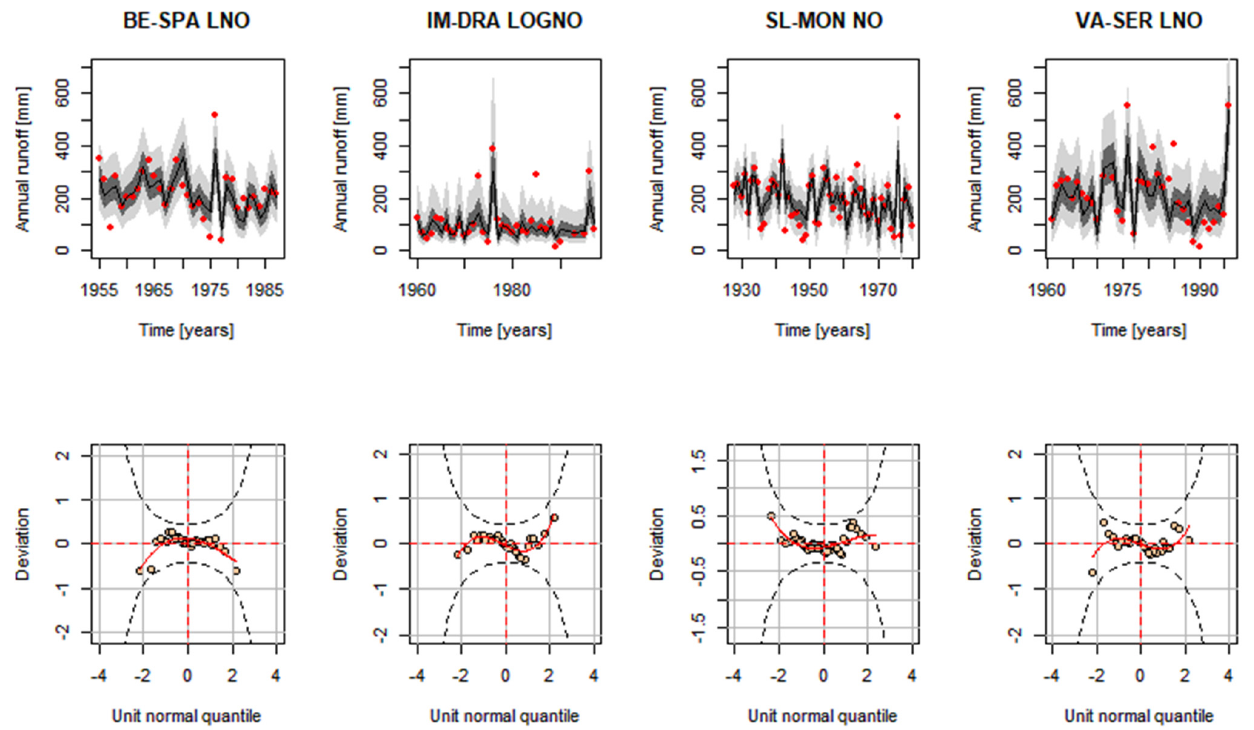
Figure 6. Summary of results for the P1 model for all the stations with generalized additive models in location, scale and shape parameters and the corresponding worm plots for runoff series. The legend for the ( first line ) is the same as in Figure 5.